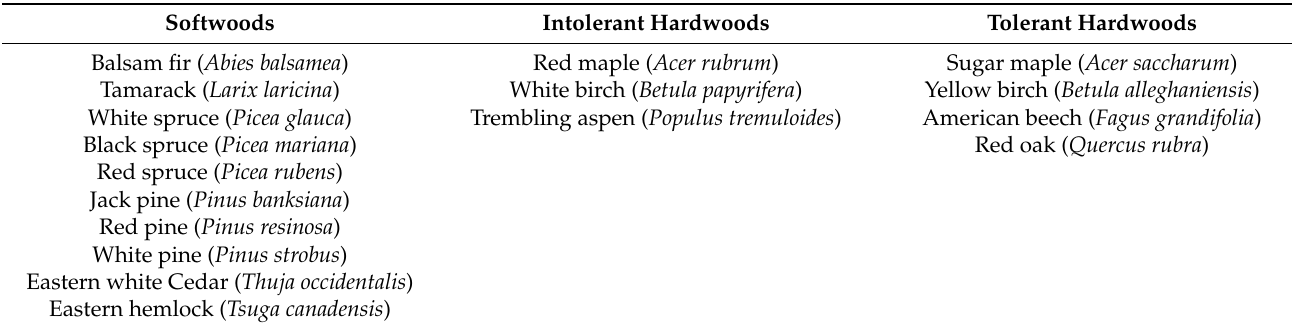
Table 1. List of species used in the simulations of Maskinong é